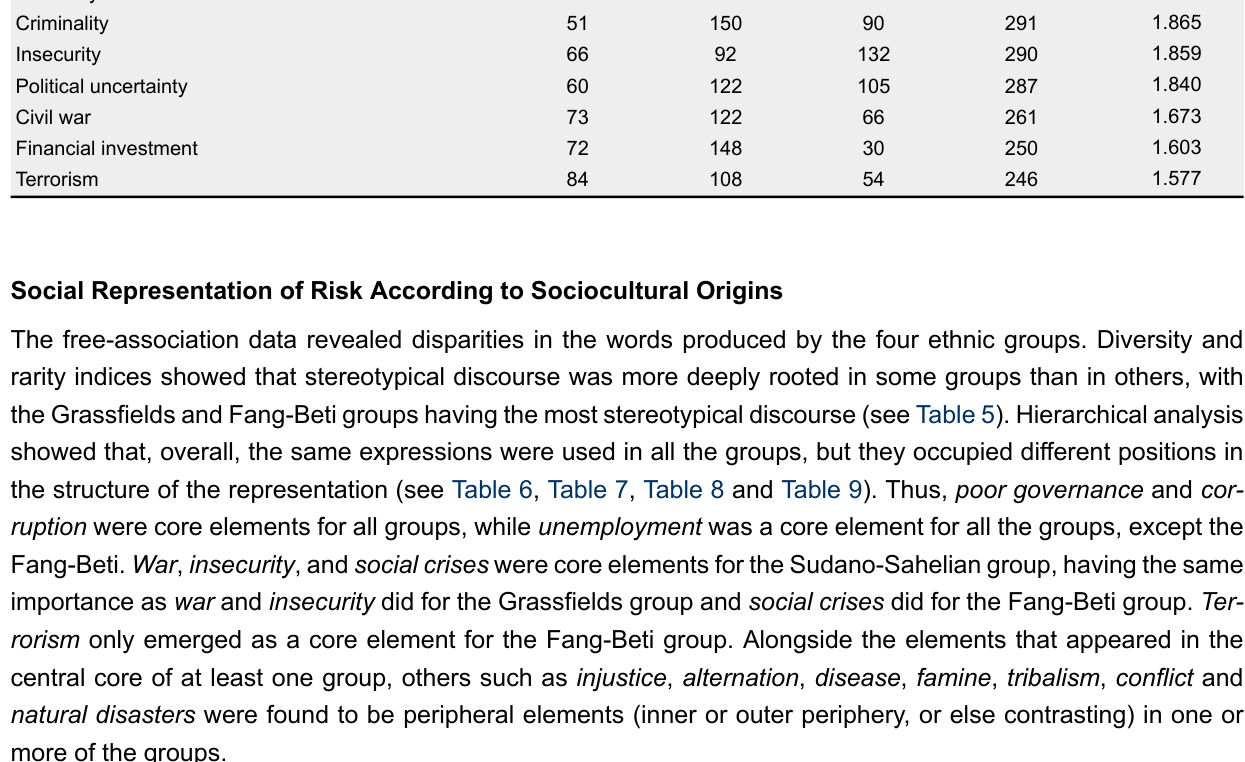
Mean Number of Free Associations, Diversity and Rarity Indexes in Each Ethnic Group